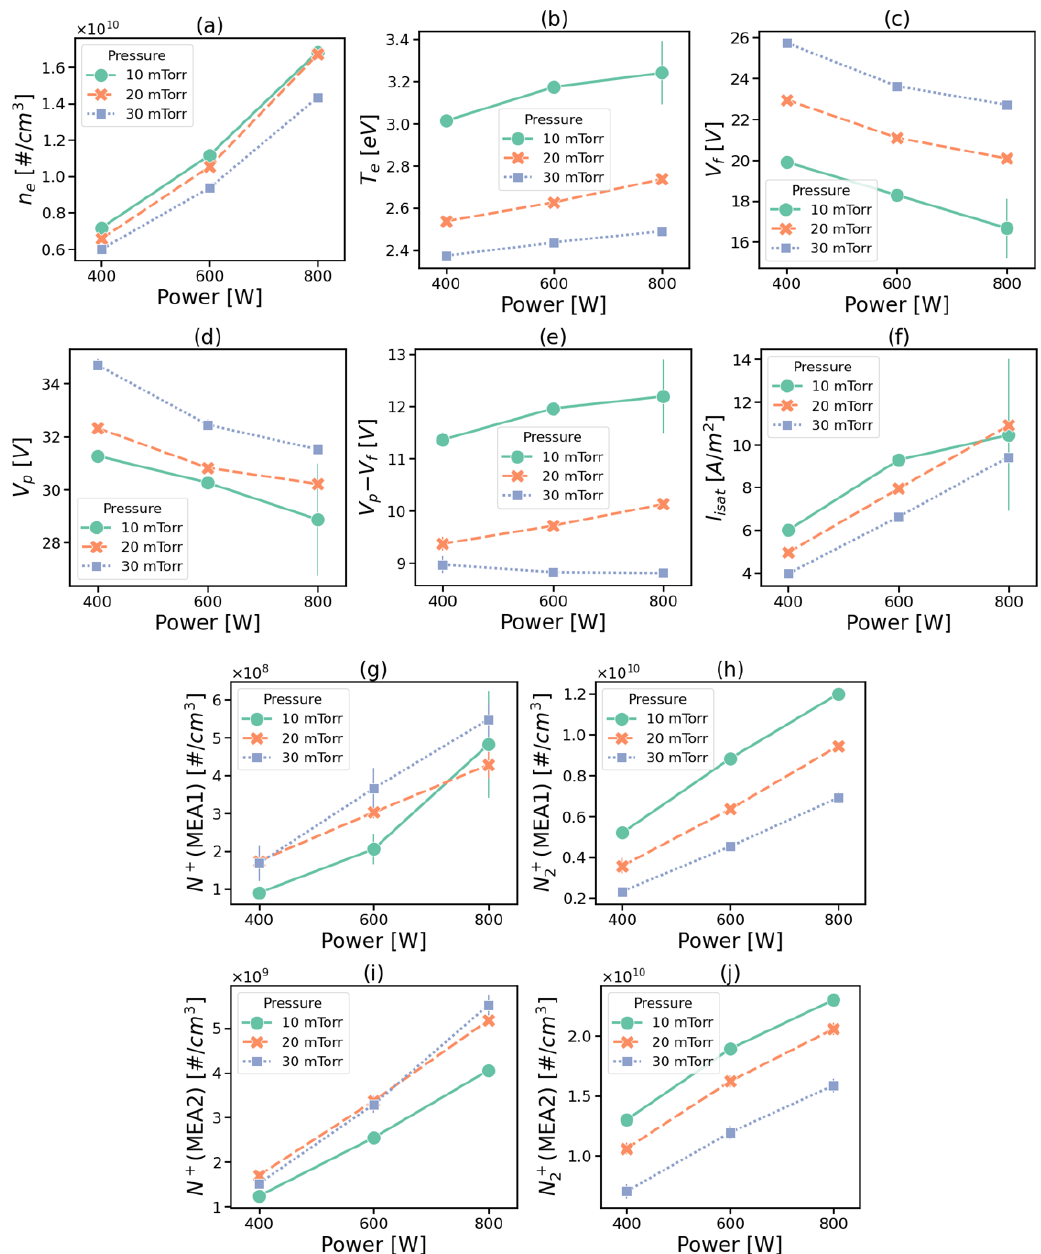
Figure 2. Plasma characteristics of PN-ICP system. ( a ) Electron density ( 𝑛 e ), ( b ) electron temperature ( 𝑇 e ), ( c ) floating potential ( 𝑉 f ), ( d ) plasma potential ( 𝑉 p ), ( e ) acceleration potential (𝑉 a = (𝑉 p − 𝑉 f )) , ( f ) ion saturation current ( 𝐼 isat ), and N + , N 2+ ion number (#) density of MEA1(wall) ( g , h ) and MEA2 (substrate) ( i , j ). N 2 gas flow rate: 66 sccm (10nTorr), 119 sccm (20 mTorr), and 174 sccm (30mTorr).